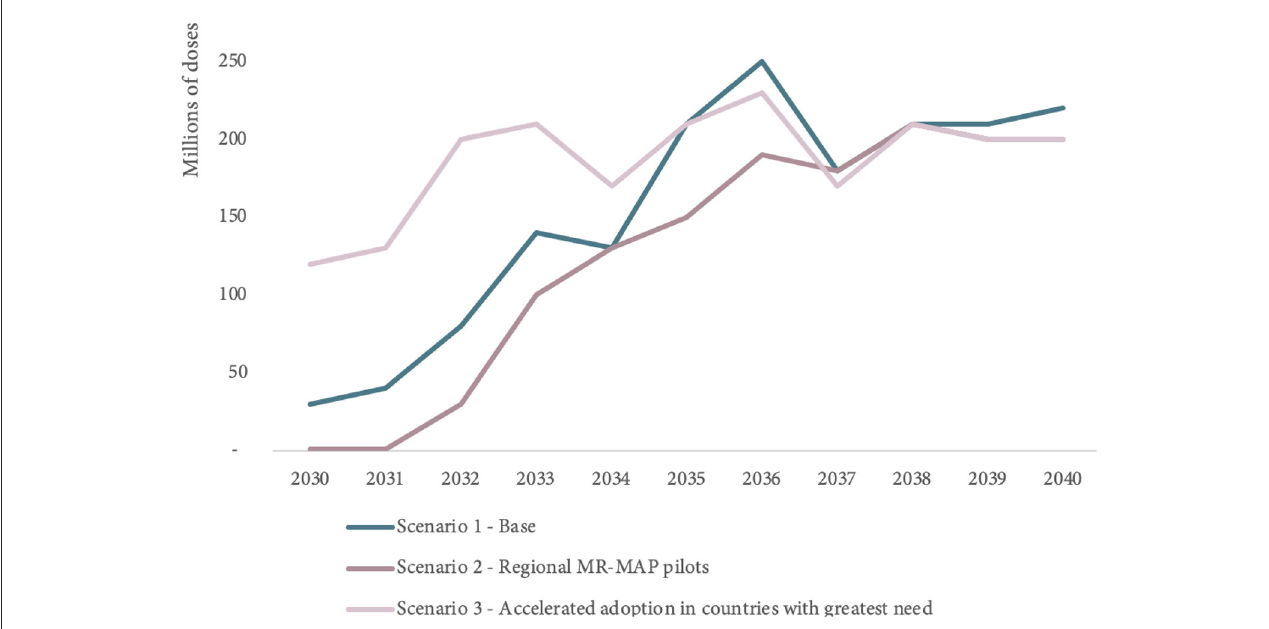
FIGURE6 Comparison of global MR-MAP PDR by scenario, between 2030 and 2040. PDR, programmatic doses required; MR, measles and rubella; and MAPs, microarray